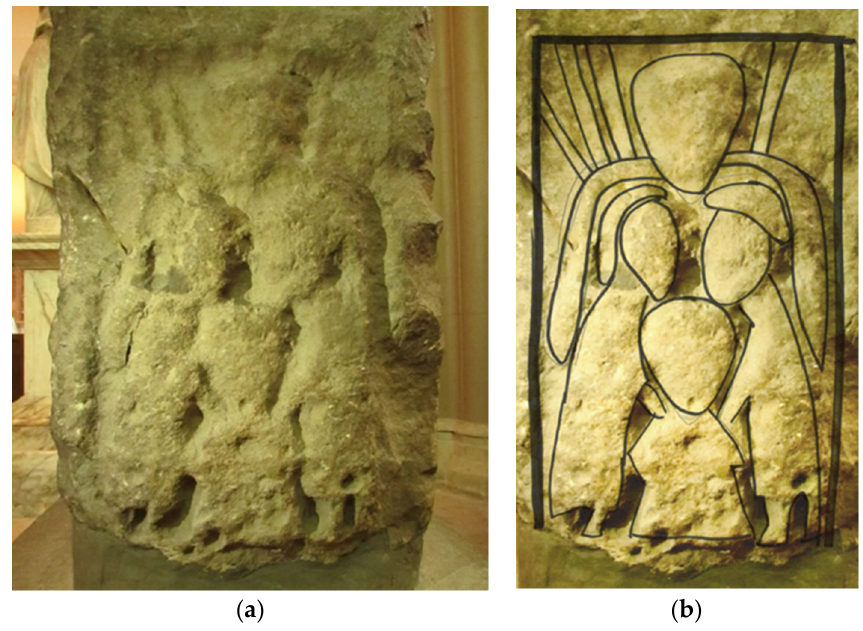
Figure 8. ( a , b ) Three Hebrews in the Fiery Furnace, N1, Armagh cross. Mid-eighth to early ninth century. St Patrick’s Church of Ireland Cathedral, Armagh, Co. Armagh. Photograph: Megan Henvey; Interpretive Sketch: Megan Henvey.